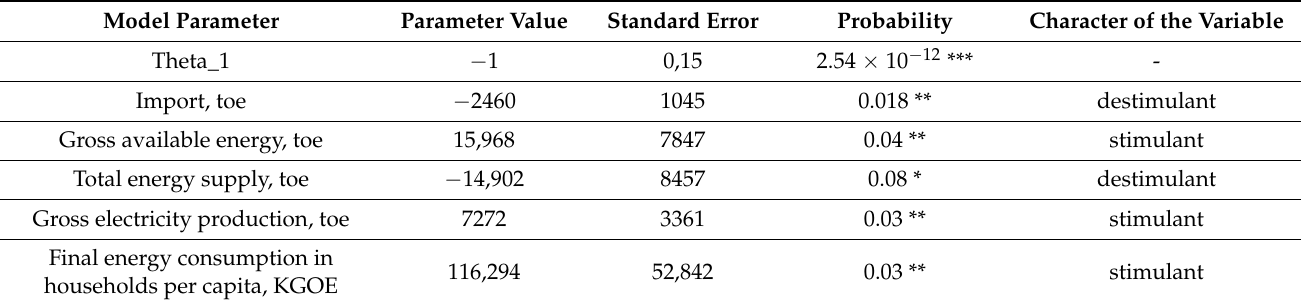
Table 2. ARMAC mode parameters (0,1,1) and evaluation of their